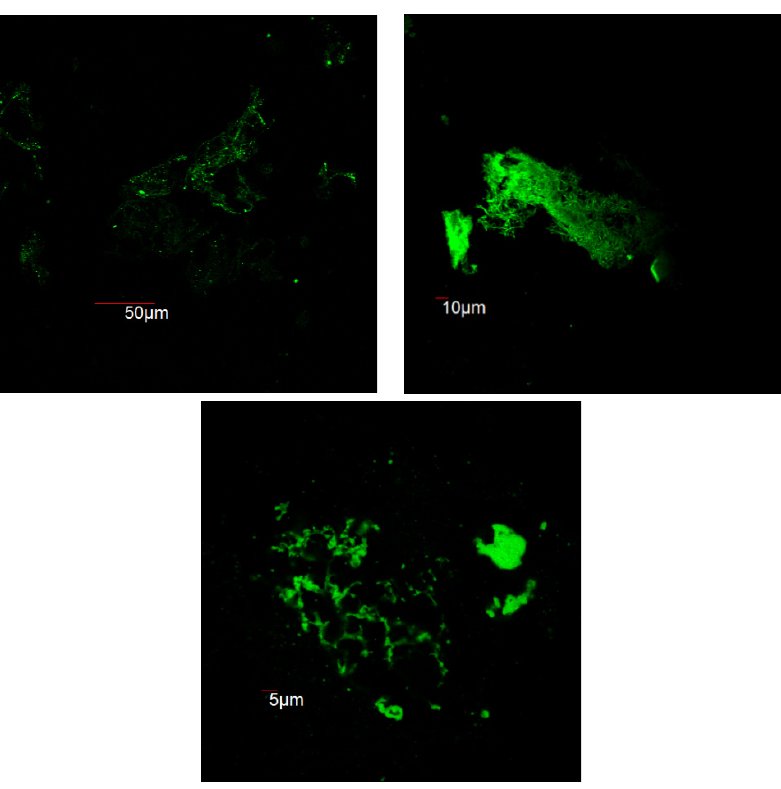
Figure 2. Confocal microscopy images of ThT-dyed amyloid fibrils taken at increasing magnifica-